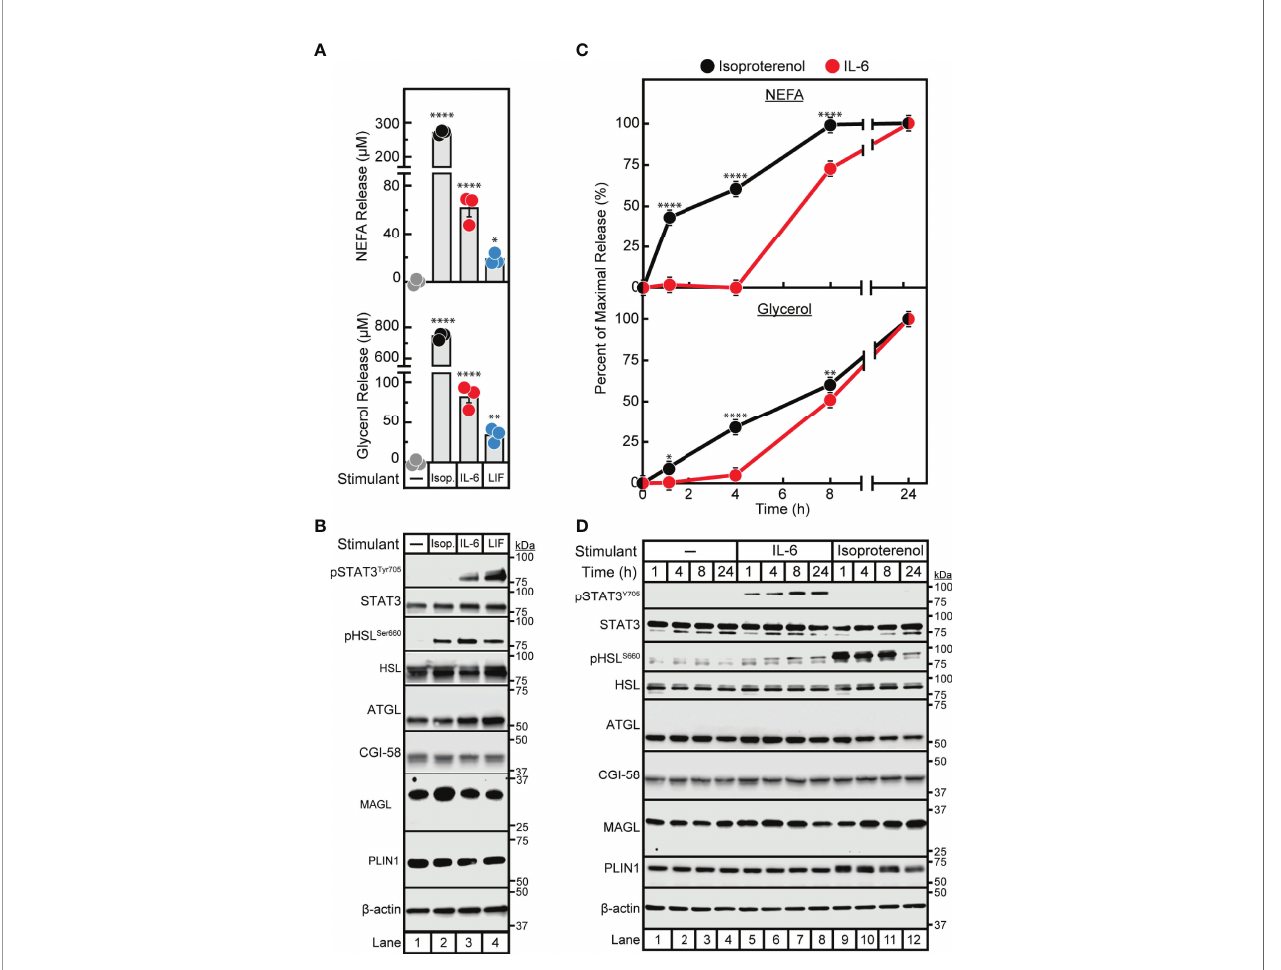
FIGURE 1 | Comparison of IL-6 Family Cytokine and b -adrenergic Adipocyte Signaling and Lipolysis. (A – D) Differentiated adipocytes in a 12-well format were treated in a fi nal volume of 1 ml of medium D with 3 µl DMSO and 3 µl PBS in the absence or presence of 300 nM isoproterenol ( black, Isop. ), 3 nM IL-6 ( red ), or 0.3 nM LIF ( blue ). After incubation (37°C, 10% CO 2 ) for either 24 hours (A, B) or the indicated time (C, D) , medium was collected and processed to measure concentrations of NEFA ( A, C ; top panels) or glycerol ( A,C ; bottom panels), and adipocytes were harvested and processed for immunoblot analysis (B, D) with the indicated antibody as described in Methods . Data is shown as mean ± SEM of three wells. * p < 0.05, ** p < 0.01, or **** p < 0.0001 based on one-way ANOVA followed by Dunnett ’ s multiple comparison test to compare each condition to the vehicle condition (A) or two-way ANOVA followed by S ̌ ida ́ k ’ s multiple comparison test to compare isoproterenol to IL-6 conditions at matched time points (B) . These results were con fi rmed in at least three independent